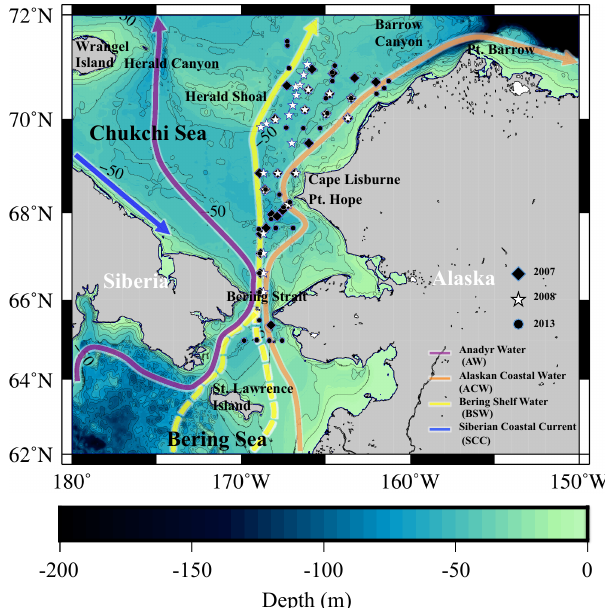
Figure 1. Study area and sampling stations in the northern Bering and Chukchi seas during the summers of 2007, 2008 and 2013. The symbols denote the sampling stations where NORPAC net and CTD water samplings were conducted. Modified from figure presented in Spall et al. (2014) and Grebmeier et al.